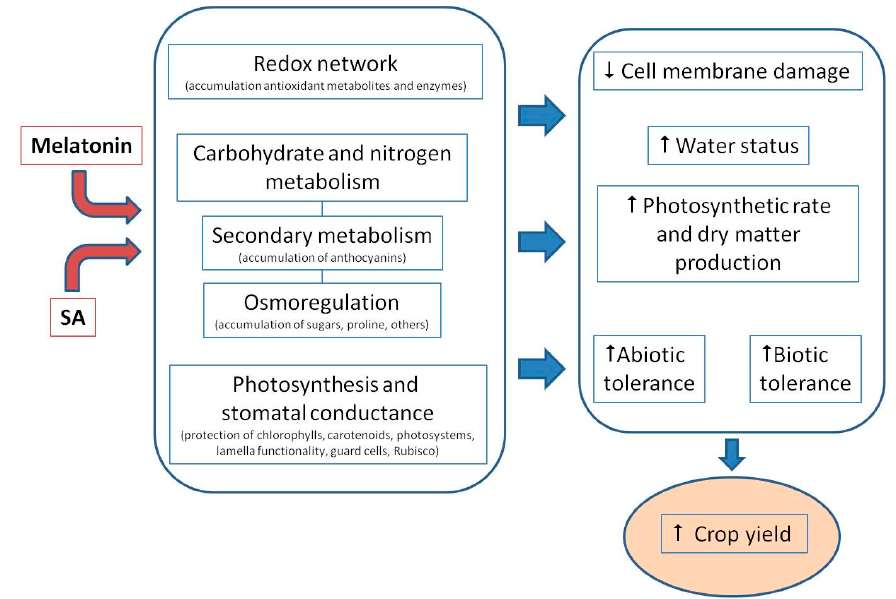
Figure 4. Melatonin/SA model of biostimulating activity in plants to enhance resistance to stress situations and increase crop yield.